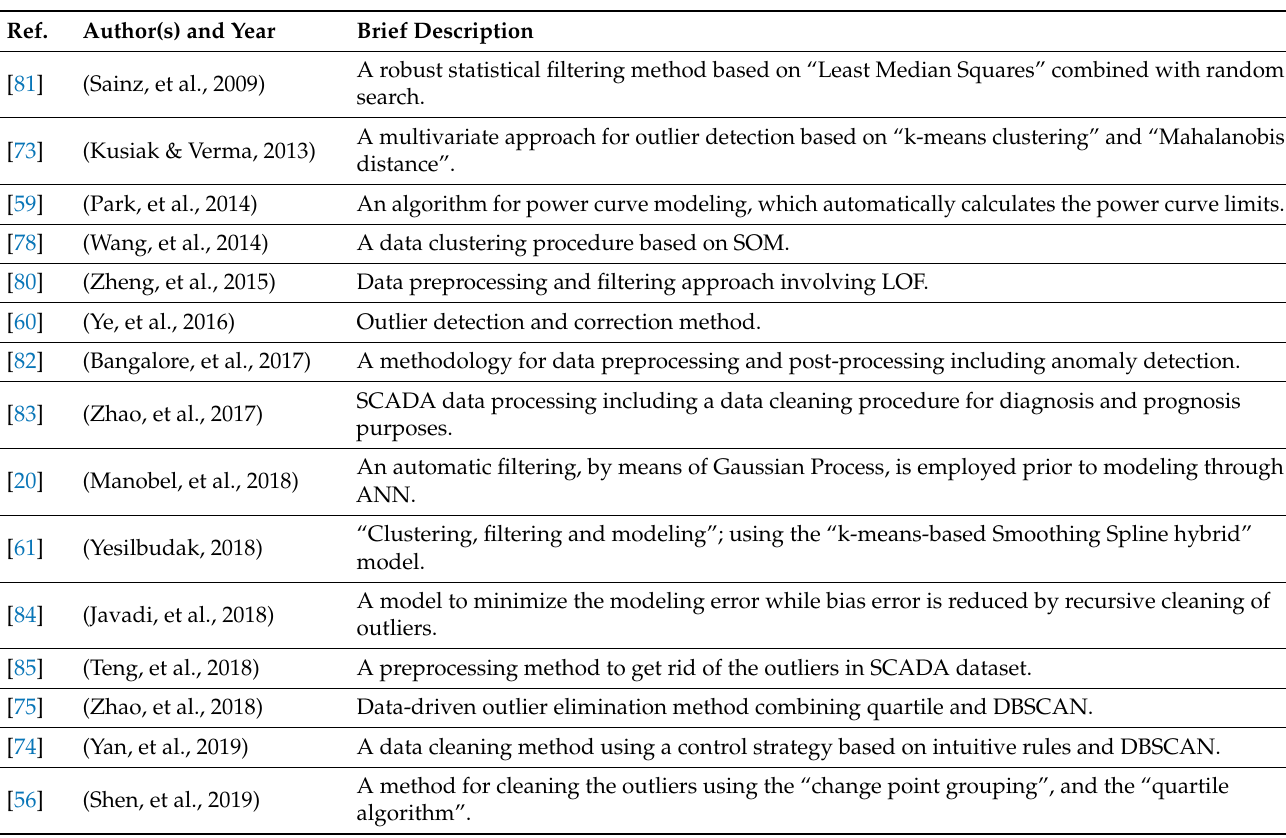
Table 5. Research articles addressing power curve data